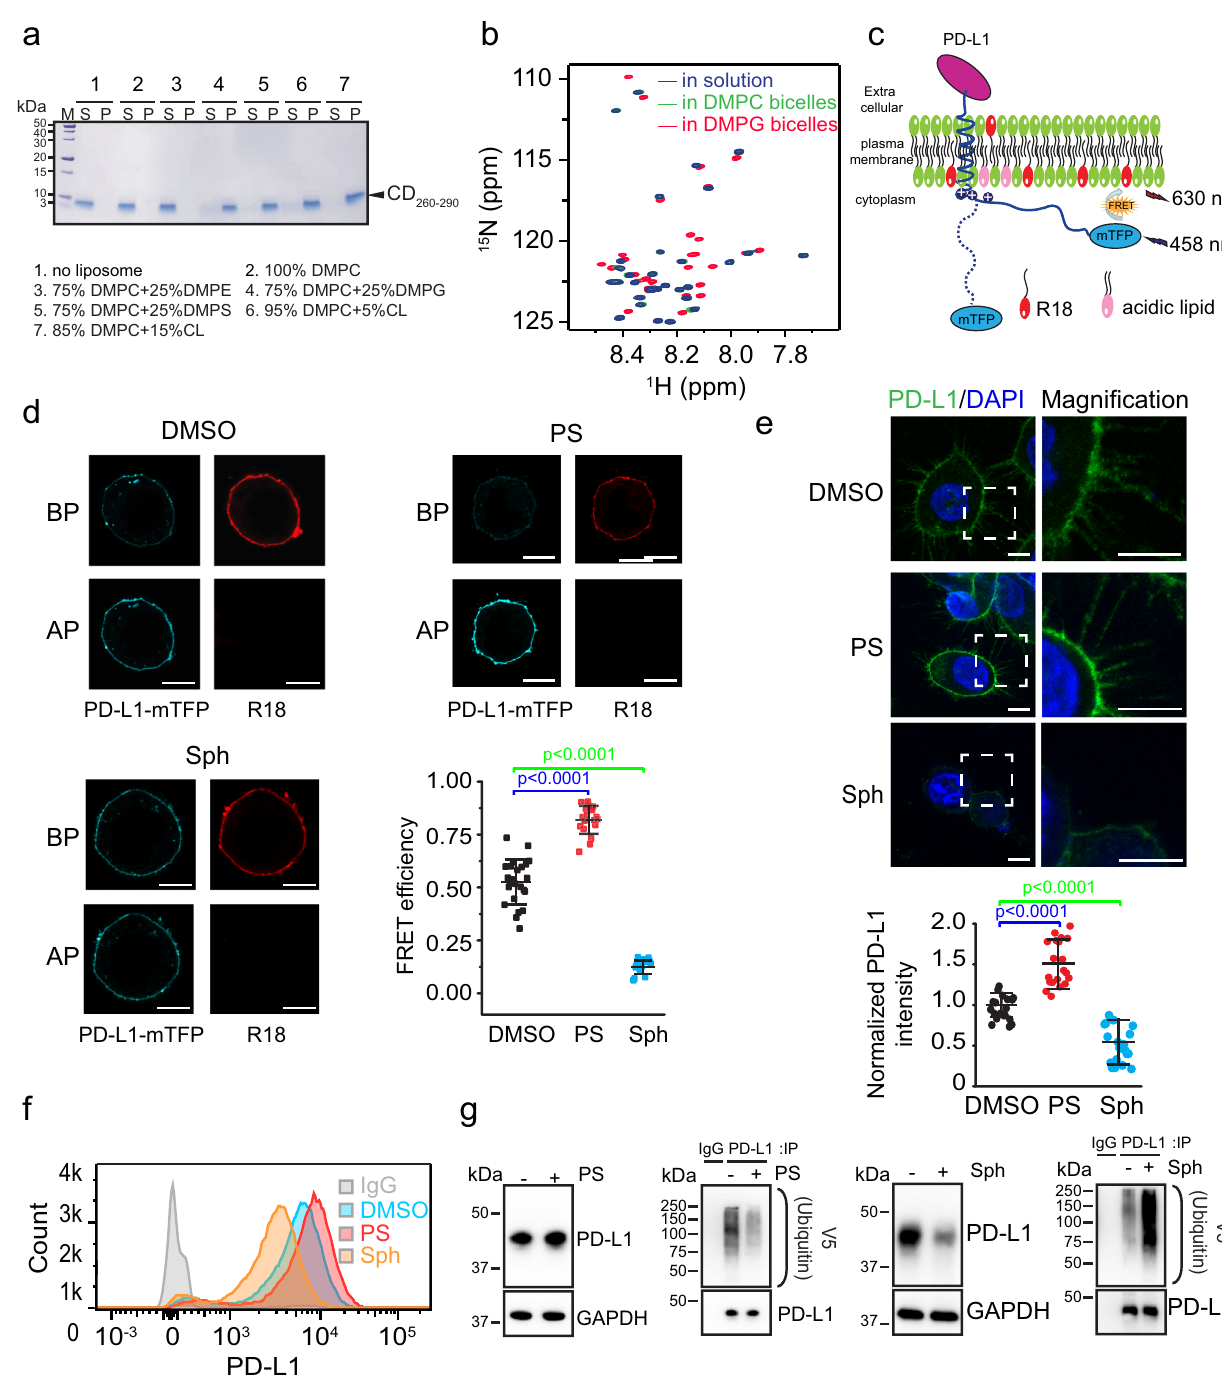
To test the effect of acidic lipids in live cells, we used fl uorescence resonance energy transfer (FRET) to monitor the membrane binding of PD-L1-CD following an established protocol 24,26 , in which the monomeric teal fl uorescent protein (mTFP) was the donor and the octadecyl rhodamine B (R18) was the acceptor (Fig. 1c). The mTFP was fused to the C-terminus of full length PD-L1 (PD-L1-mTFP). The PD-L1-mTFP fusion protein was stably expressed in RKO cells whose plasma membranes were labeled with the R18 dye. The FRET ef fi ciency between PD-L1-mTFP and the R18 dyes in the membranes was fi rst measured using the donor dequenching method. The result showed that after a treatment of the cells with PS, which increases NATURE COMMUNICATIONS| (2021) 12:5106